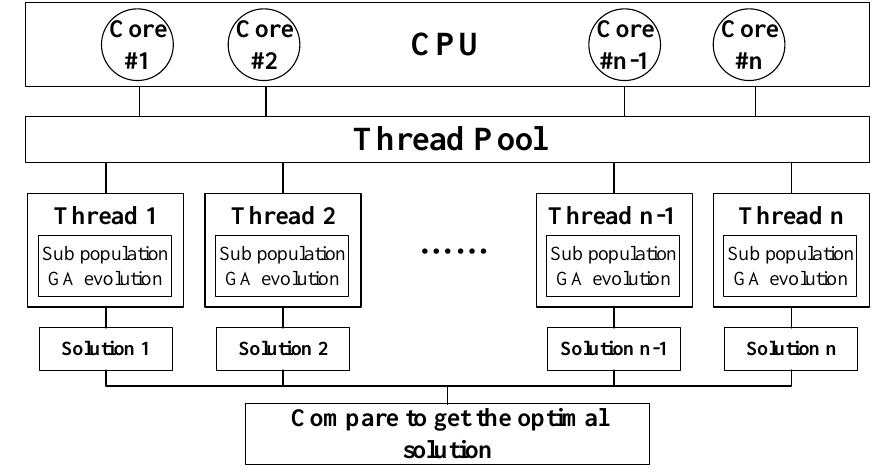
Figure 4. Multi ‐ core parallel computing strategy Figure 4. Multi-core parallel computing